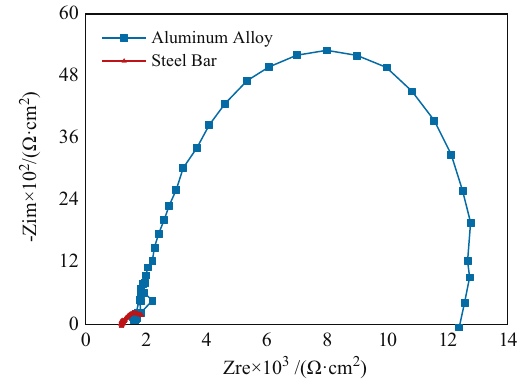
Figure 11: AC impedance spectroscopy of the aluminium alloy and steel bar in the simulated acid rain solution.